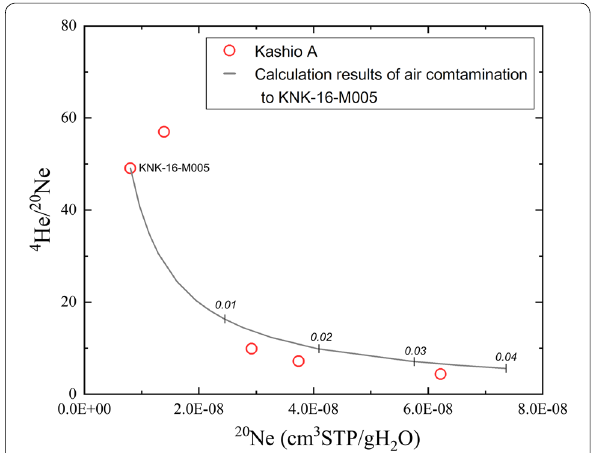
Fig. 7 Relationship between the 4 He/ 20 Ne ratio and 20 Ne concentrations in the Kashio A samples. The gray solid curve indicates the trend by adding air to the sample KNK-16-M005 up to 4.0 cm 3 STP per 10 g of sample water, based on the concentration of He and Ne and their stable isotope ratio of air (Ozima and Podosek 2002). Numbers along the curve indicate the amount of air added (cm 3 STP per 10 g of sample water). The variation of 4 He/ 20 Ne ratio and 20 Ne concentration in Kashio A samples is clearly explained by air